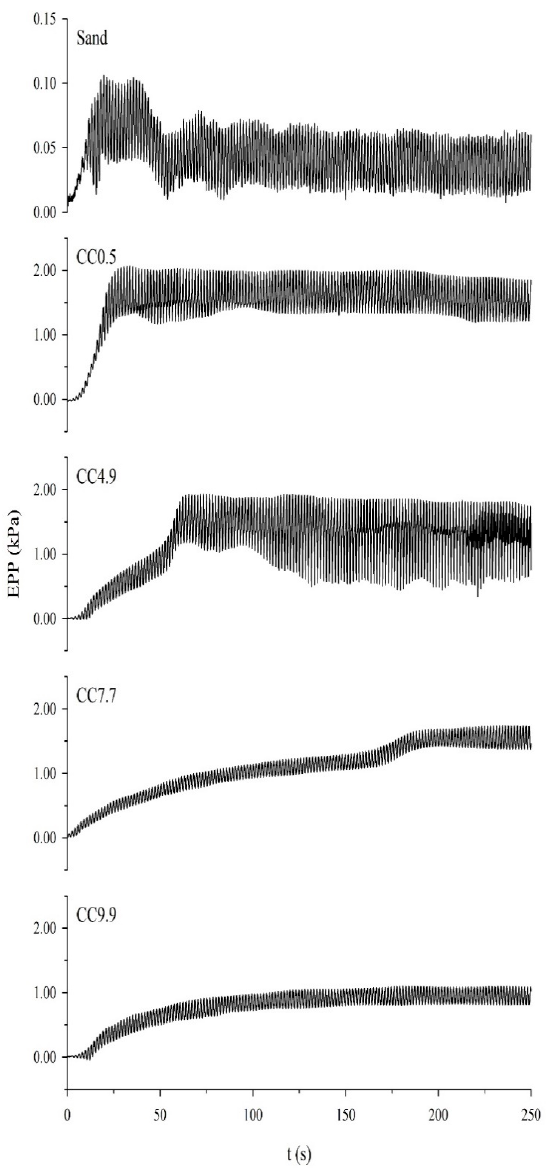
Figure 4. Excess pore water pressure (EPP) in mixed bed at z = 0.23 m (the wave height is 0.14 m and the wave period is 1.6 s).